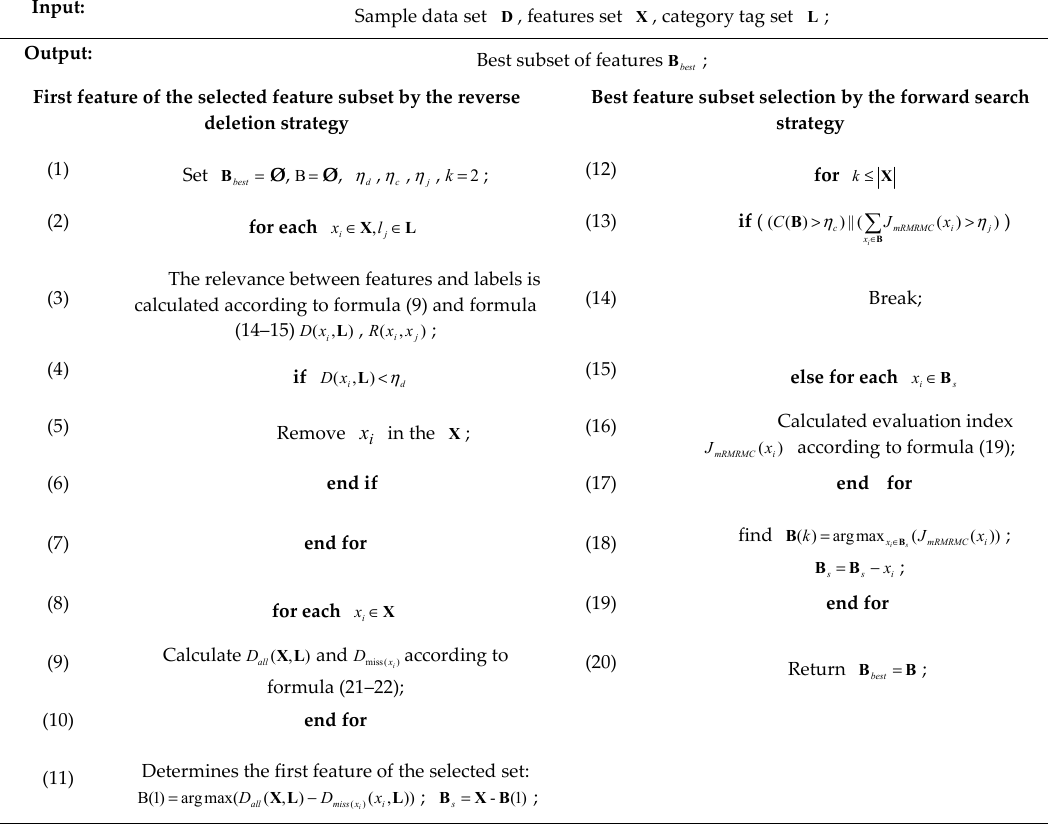
Figure 7. The solution process of the proposed algorithm.